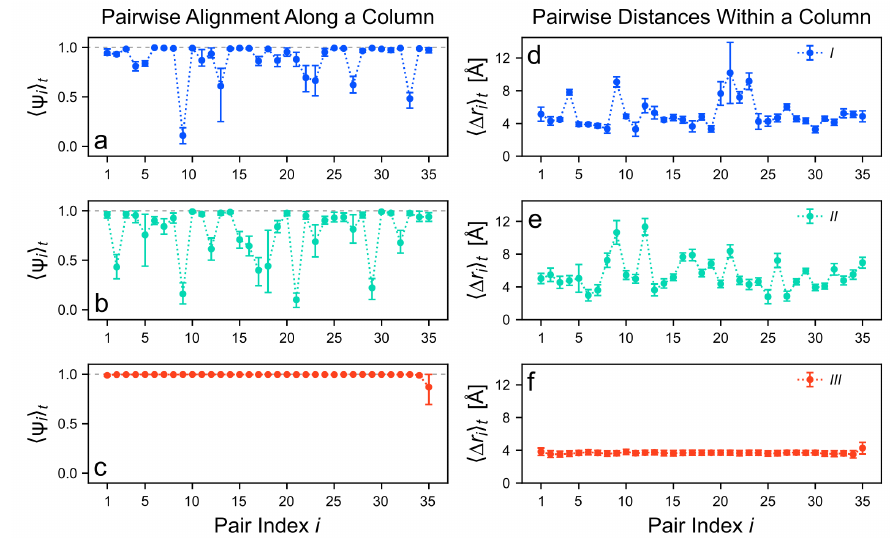
Figure 6. ( a – c ) Time averages of the local columnar orientation order parameter, (cid:104) Ψ i (cid:105) t . ( d – f ) Time averages of the pairwise distances, (cid:104) ∆ r i (cid:105) t . Both observables are plotted as a function of the pair index i along the stack. The largest simulated clusters ( N = 36) are shown for each cluster type. The error bars in ( a – c ) delimit 68% confidence intervals. In ( d – f ) standard deviation error bars are used. Dashed gray lines in ( a – c ) indicate the largest possible value of (cid:104) Ψ i (cid:105) t . Dotted lines between the symbols serve as a guide to the